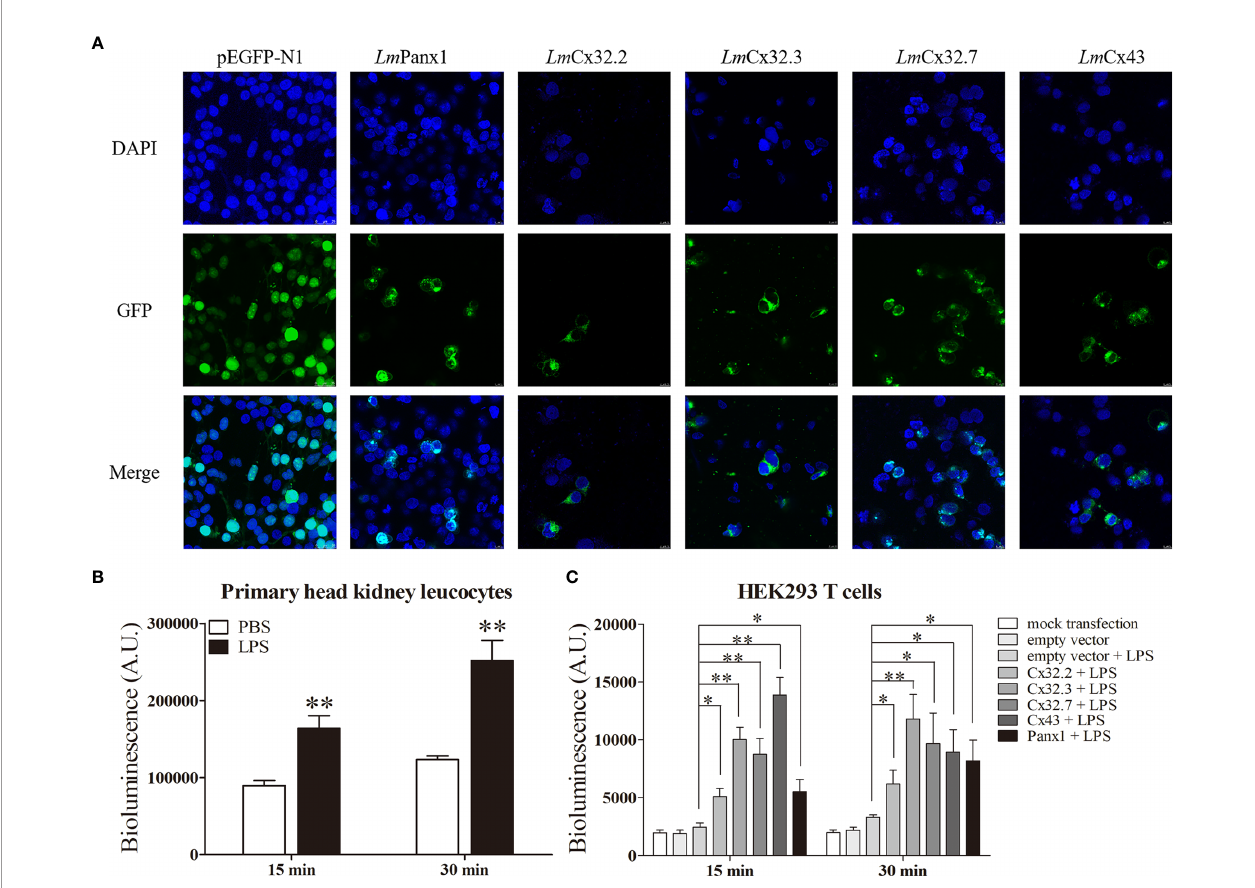
FIGURE 8 | Subcellular localization of Lm Panx1, Lm Cx32, and Lm Cx43 in HEK293 T cells (A) and LPS-induced extracellular ATP release in primary head kidney leukocytes (B) or HEK293 T cells (C) . (A) HEK293 T cells were transfected with pEGFP-N1- Lm Panx1, pEGFP-N1- Lm Cx32.2, pEGFP-N1- Lm Cx32.3, pEGFP-N1- Lm Cx32.7, or pEGFP-N1- Lm Cx43 plasmids. At 24 h posttransfection, the cells were stained with DAPI and observed under a confocal microscope. (B, C) The primary head kidney leukocytes were stimulated with LPS (100 µg/mL) or PBS (control). HEK293 T cells were transfected with pcDNA3.1- Lm Panx1, pcDNA3.1- Lm Cx32.2, pcDNA3.1- Lm Cx32.3, pcDNA3.1- Lm Cx32.7, or pcDNA3.1- Lm Cx43. After 24 h, the cells were stimulated with LPS (100 µg/mL). The supernatant was collected at 15 and 30 min after stimulation and the ATP levels were subsequently measured. The mock transfected and empty plasmid transfected cells served as controls. Data are shown as mean +SEM (N = 4). * p < 0.05, ** p < 0.01 are considered signi fi cant